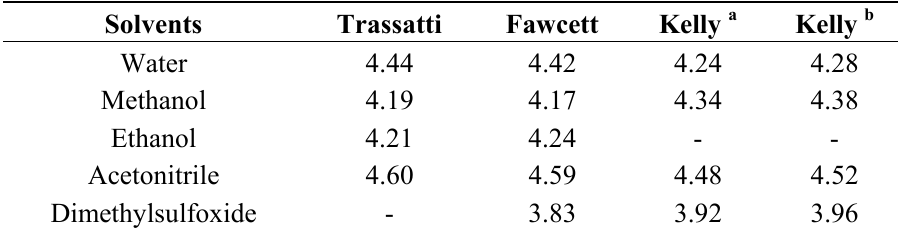
Table 1. Absolute potentials of the standard hydrogen electrode (SHE) (V) in different solvents and from different